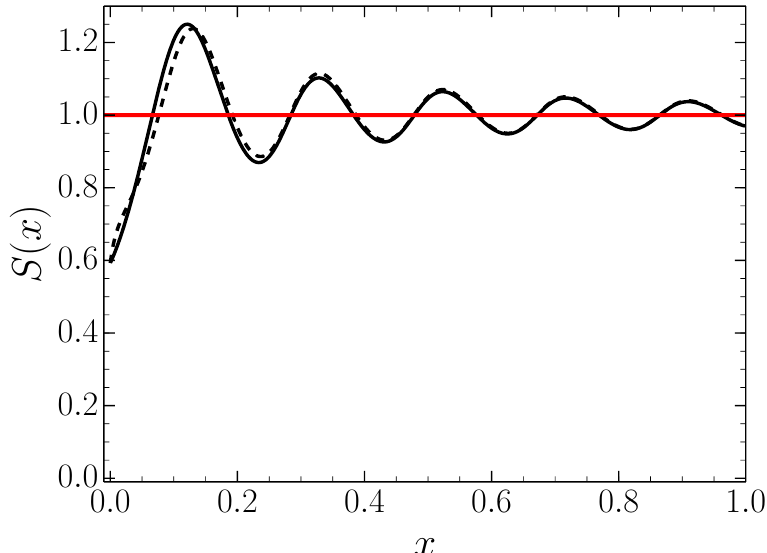
Figure 9. Regge–Wheeler for Schwarzschild: Scalar cross section . Dimensionless (scalar) cross section derived from the toy model # 3, Equation (41), for scalar greybody factors. Note the solid curve is based on the numerical data, while the dashed curve is from our model # 3. The fit is generally quite good and the curves are often indistinguishable to the naked